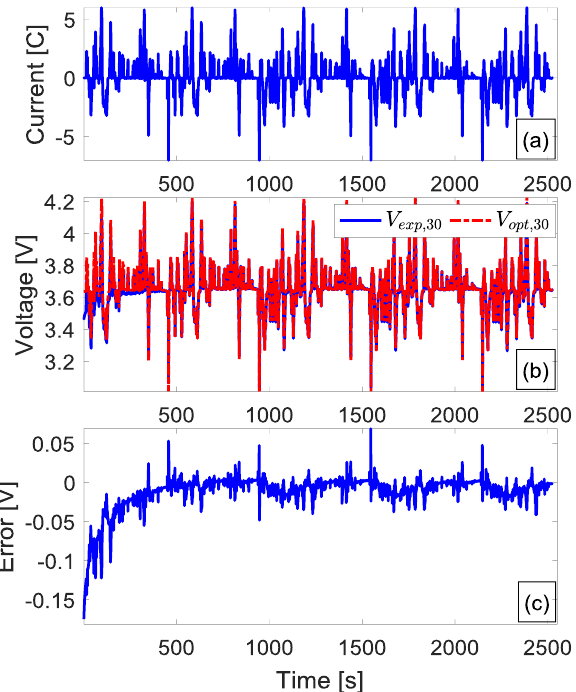
Figure 8. Validation results under US06 condition at 30 °C: ( a ) input current profile; ( b ) voltage; and ( c ) voltage error.